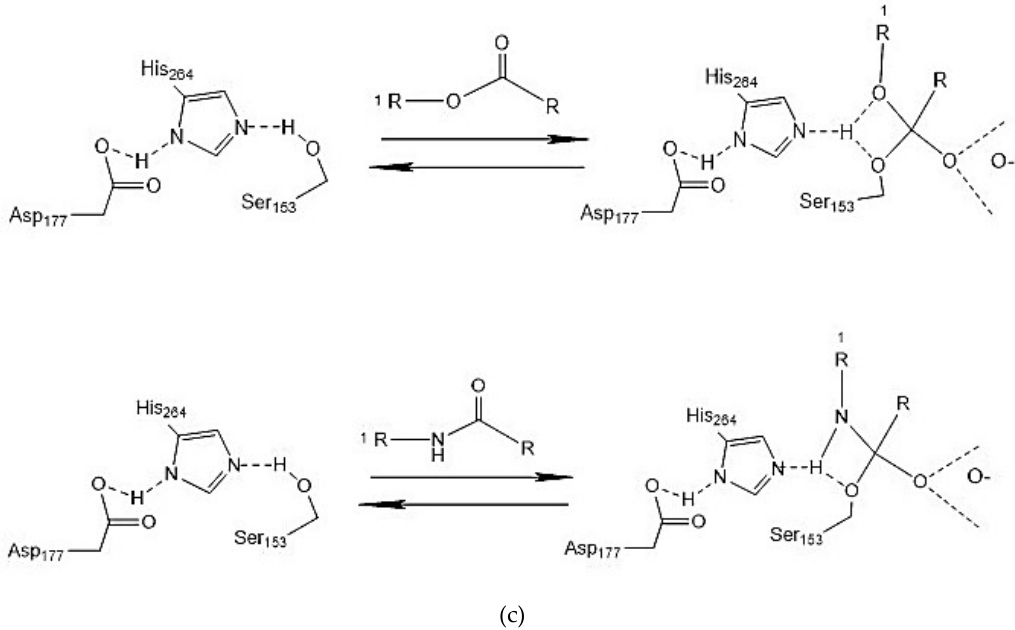
Figure 2. ( a ) Inhibition of lipase by the synthesized peptide by Copper soap method. ( b ) Docking analysis of the porcine pancreatic lipase (PDB code: 1ETH) with the decapeptide, showing hydrogen bond (blue sagittate), Van der Waals (green), and Electrostatic (pink). Two-dimensional diagrams of predicted interactions between the decapeptide and the porcine pancreatic lipase (PDB code: 1ETH), (A) PP1 (B) simvastatin, and (C) Orlistat. ( c ) Catalytic mechanism of lipase with lipid and polypeptide.